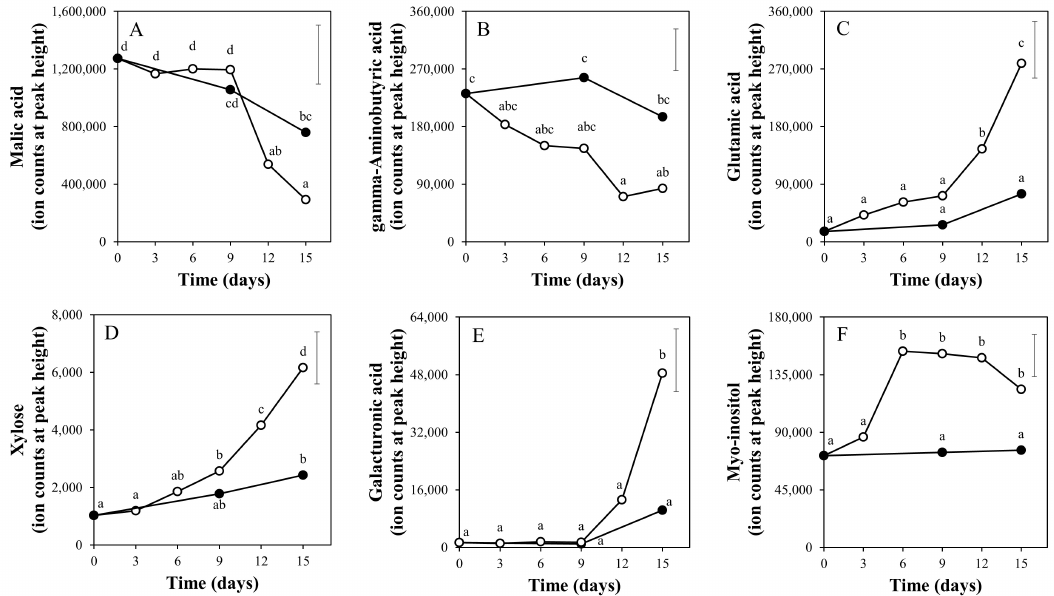
Figure 5. Relative levels of selected metabolites in tomato pericarp from experiment 1, measured by GC-MS. The fruits were treated with white light (500 μmol m −2 s −1 ; open symbols) or darkness (closed symbols) for 15 days and sampled at indicated days. Error bars indicate the least significant difference; letters ( A – F ) indicate significant differences between treatments or days at α = 0.01, n = 3 (three pools of two fruits each).